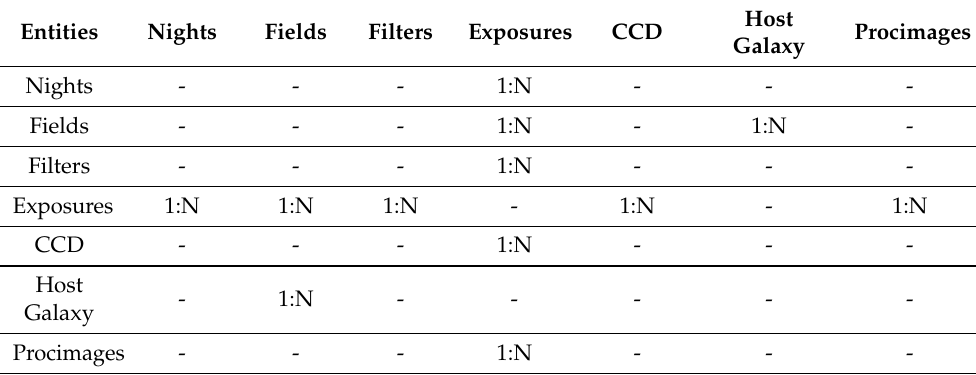
Table 4. Matrix of the entities of the